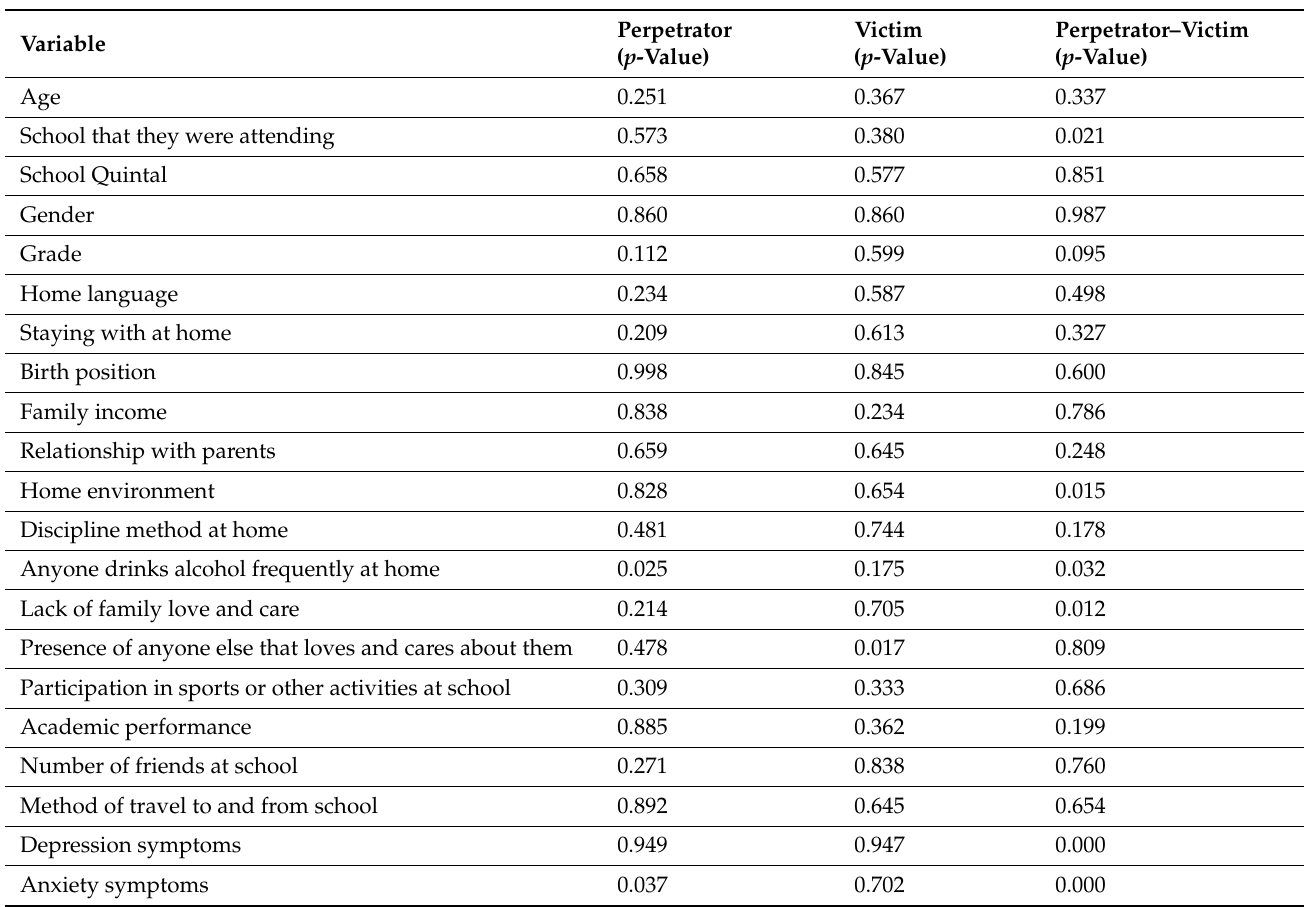
Table 2. Pearson Chi 2 test of association between bullying behavior (perpetrator, victim, and perpetrator–victim) and socio-demographic